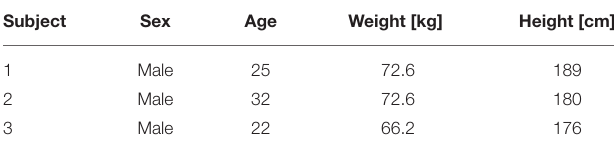
TABLE 1 | Summary of the participant information involved in this study.